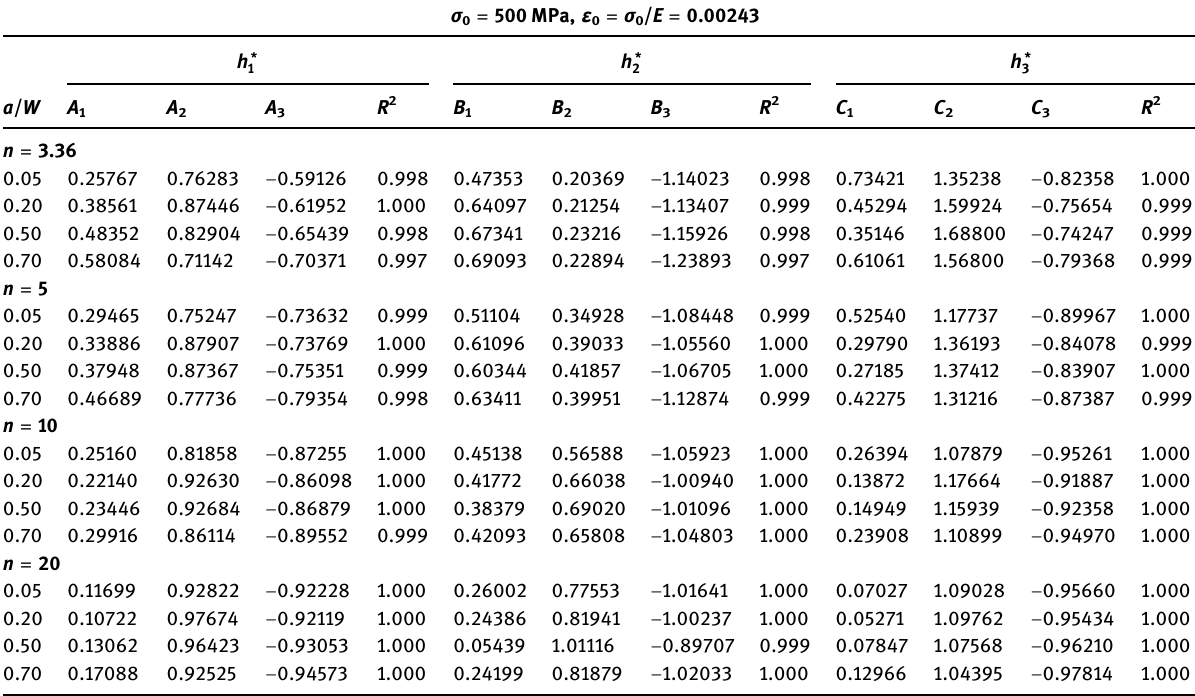
Table 3: Coe ffi cients of matching equations ( 11 – 13 ) to the obtained numerical results for materials described with the yield point σ